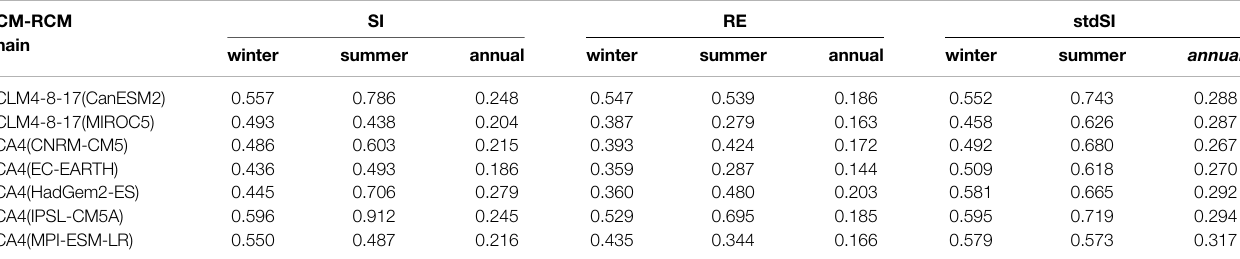
TABLE3| Performanceindexes(SI,RE,stdSI)calculatedforeachRCMsimulationatwinter,summer,andannualscale.BestperformanceintermsofSIandREisshownby RCA4(EC-EARTH) (annual and winter scale) and CCLM(MIROC5) (summer scale). GCM-RCM